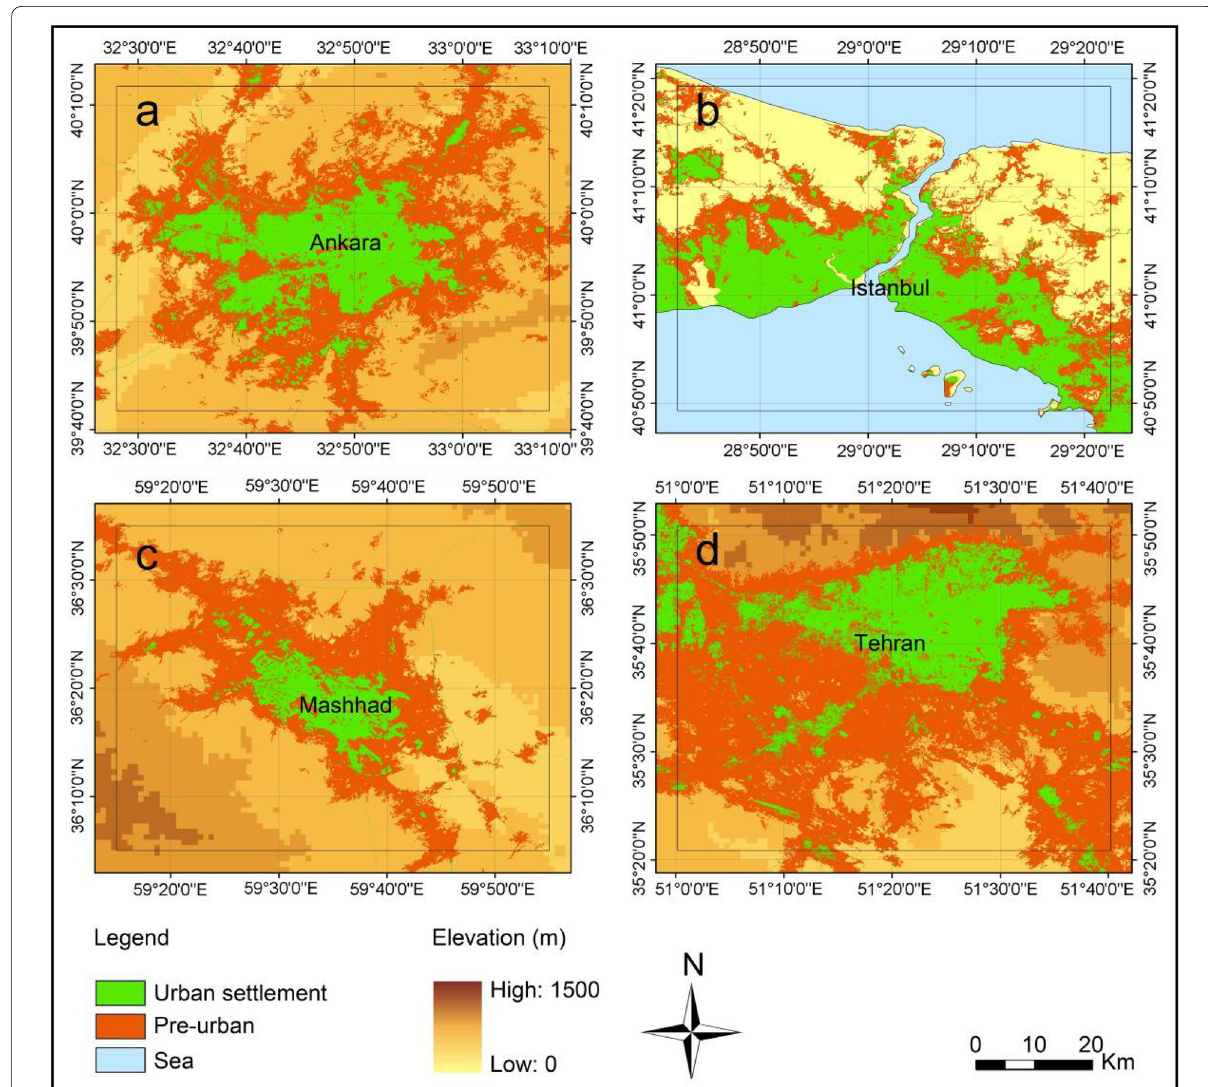
Fig. 2 Rectangle zone of each study area comprised of urban and pre‑urban expansions in 2018 for a Ankara, b Istanbul, c Mashhad, and d Tehran